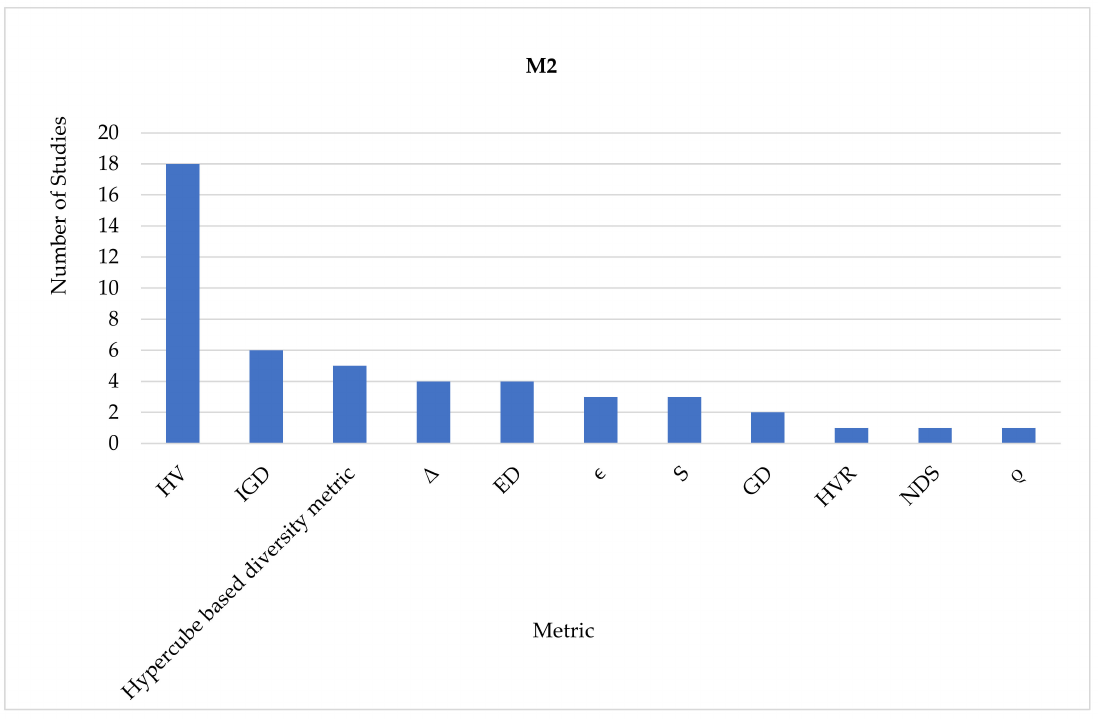
Figure 5. Metrics distribution in M2 group.